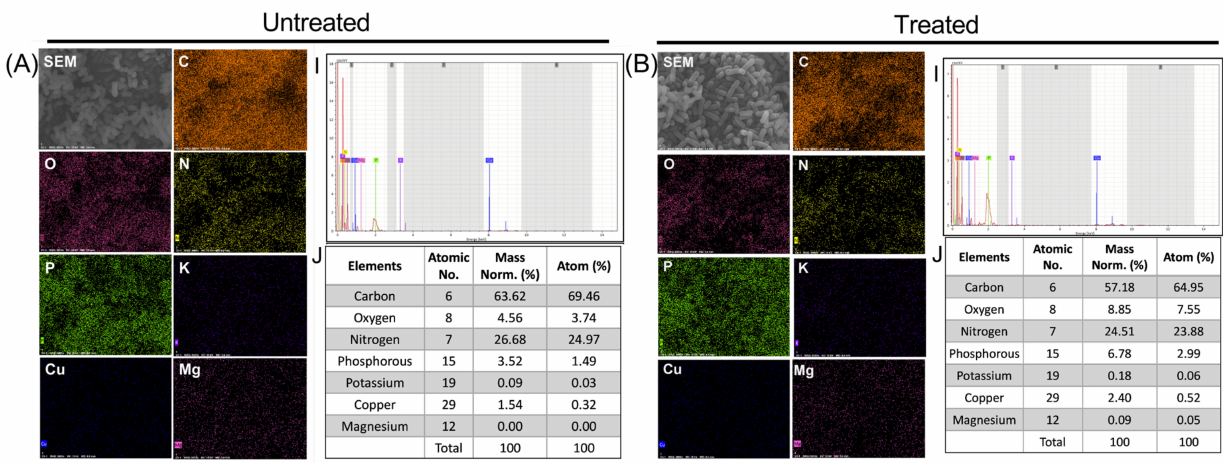
Figure 8. EDS elemental mapping displayed the distribution of elements in the PG-NOW untreated ( A ) and treated samples ( B ) of the E. coli strain, which shows the SEM image of the bacterial structure together with carbon (C), oxygen (O), nitrogen (N), phosphorous (P), potassium (K), copper (Cu), and magnesium (Mg)and their spectra with mass percentage.